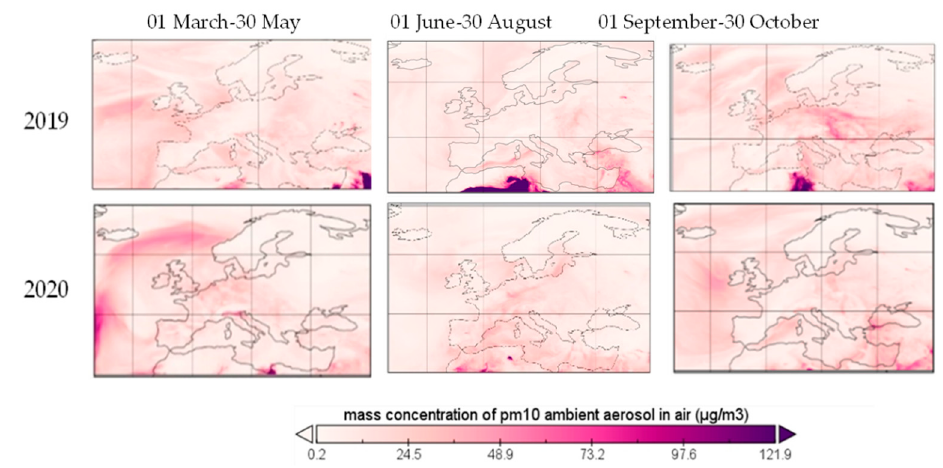
Figure 12. PM 10 over Europe during restriction period, 2019 and 2020.